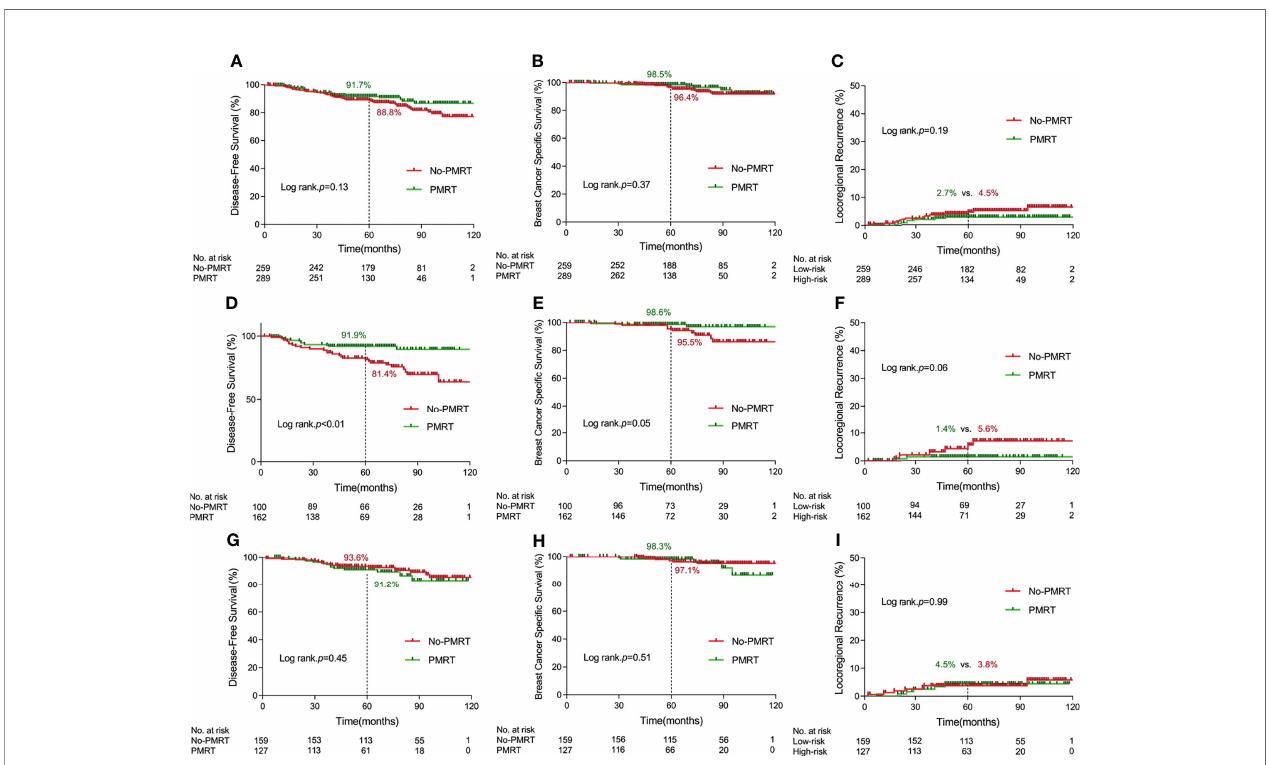
FIGURE 2 | Kaplan – Meier curves for 5-year disease-free survival, 5-year breast cancer speci fi c survival, and 5-year locoregional recurrence according to delivery of postmastectomy radiotherapy in terms of different cohorts. [ (A – C) in the whole cohort; (D – F) in the high-risk subgroup; (G – I) in the low-risk group] (PMRT, postmastectomy